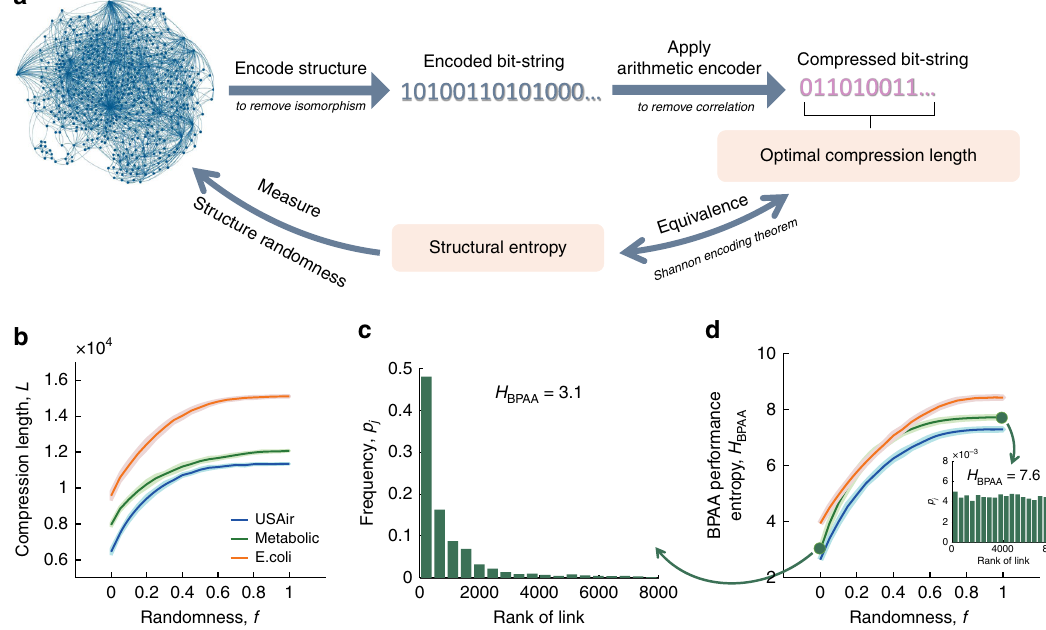
Fig. 1 Network compression and BPAA performance entropy. a Illustration of compression on network structural information. The lossless compression algorithm converts the network structure into a binary string, without retaining the labels of the nodes, and then compress the bit string to achieve the shortest compression length. b The shortest compression length of the shuf fl ed networks. Here the shuf fl ing operation is that we randomly pick f fraction of links from the original network and rewire them randomly. The compression length increases monotonically with f until f = 1, when the network becomes ER network. c Distribution of r i of Metabolic network 29 . Here we use RA algorithm 30 to do the prediction and each bar has the width equal to the network size N . The entropy of this distribution is representing the overall predictability. d The BPAA performance entropy H BPAA vs. the link shuf fl ing fraction f . We can see a monotonic trend similar to ( b ) is present for all of the three networks. Each line is the average of 50 simulations and the shaded region denotes the standard deviation. (Inset) Distribution of r i of ER network with the same number of nodes and links as Metabolic network. The value of p j is the average of 50 algorithm performance entropy H approaches that of ER networks with a nearly uniform distribution of D (Fig. 1d inset).